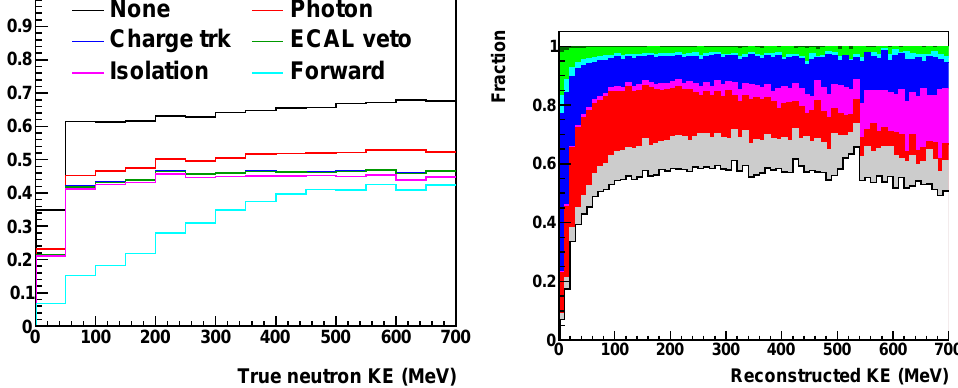
Figure 84. On the left, selection efficiency as a function of the true neutron kinetic energy for the different selection cuts applied in RHC mode. On the right, the cumulative purity as a function of the reconstructed kinetic energy in RHC mode. A purity of around 55% can be achieved for energies above 100MeV. The fluctuations seen for energies above 300MeV are due to the low statistics at these higher energies, as seen in Figure 83. Different colors correspond to the same background categories as shown in Figure 83. White is the